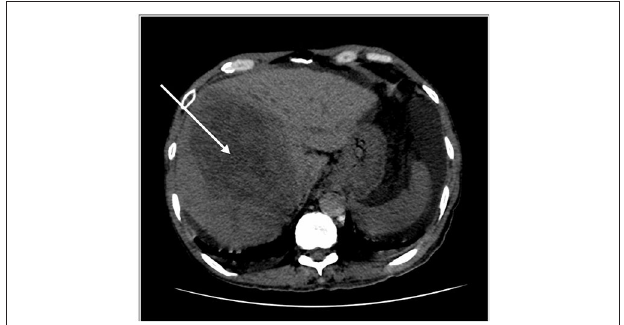
FIGURE 1 | HRCT thorax, including the liver. Key images of two scans of the same patient, at the same slice taken 3 weeks apart. The initial scan shows a large right liver lobe mass (white arrow). Please note that no obvious lesion is seen in the left liver lobe.